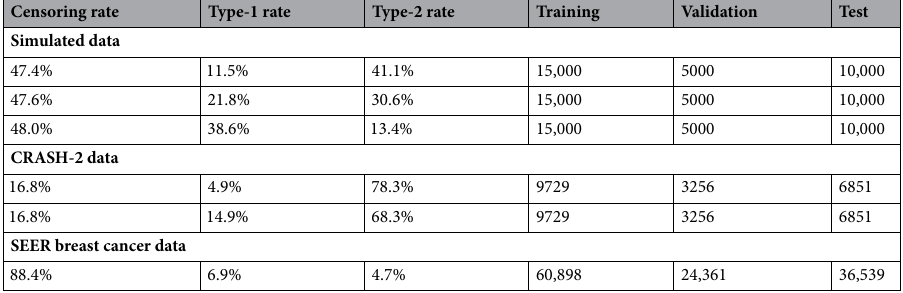
Table 1. Characteristics of the datasets used in the experiments. The three leftmost columns represent the censoring, type-1 ( ǫ = 1 ), and type-2 ( ǫ = 2 ) rates in the training/validation/test datasets. The three rightmost columns represent the respective numbers of instances in the simulated, CRASH-2, and SEER breast cancer data. For CRASH-2, ǫ = 1 indicates either death due to bleeding event (upper row) and death due to any recorded cause (lower